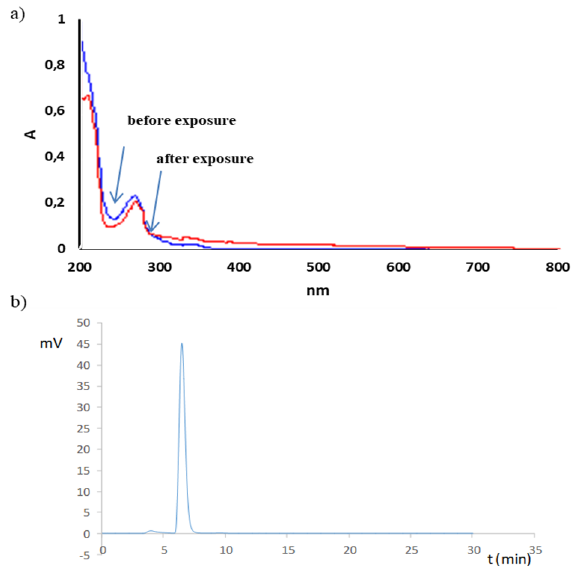
Figure 7. UV ( a ) and HPLC-UV ( b ) analysis of phenol solution (0.5 mg/mL) subjected to photodegradation (1.2 · 10 6 lux · h).